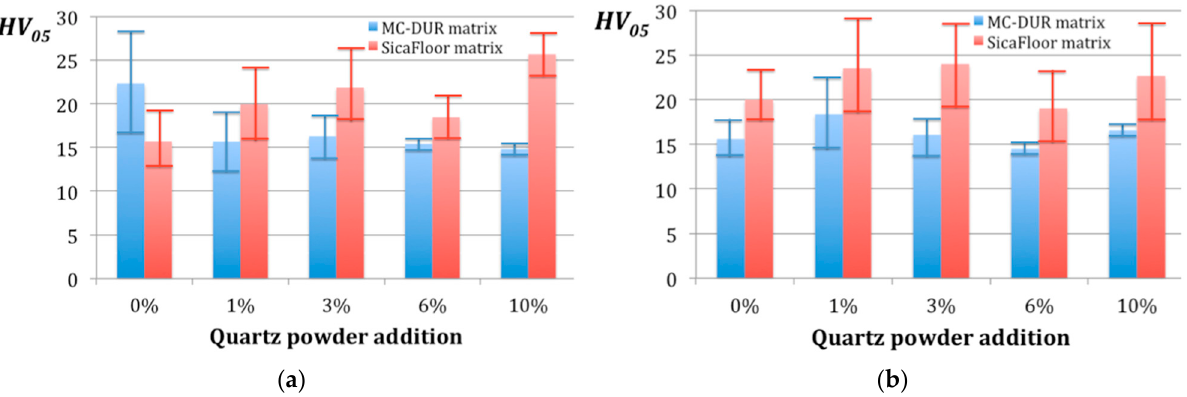
Figure 3. Microhardness HV 05 dependent on the particulate filler proportions for the composites with the polymer matrices MC-DUR 1200VK and Sikafloor 156: ( a ) with the emulsion binder; ( b ) with the powder